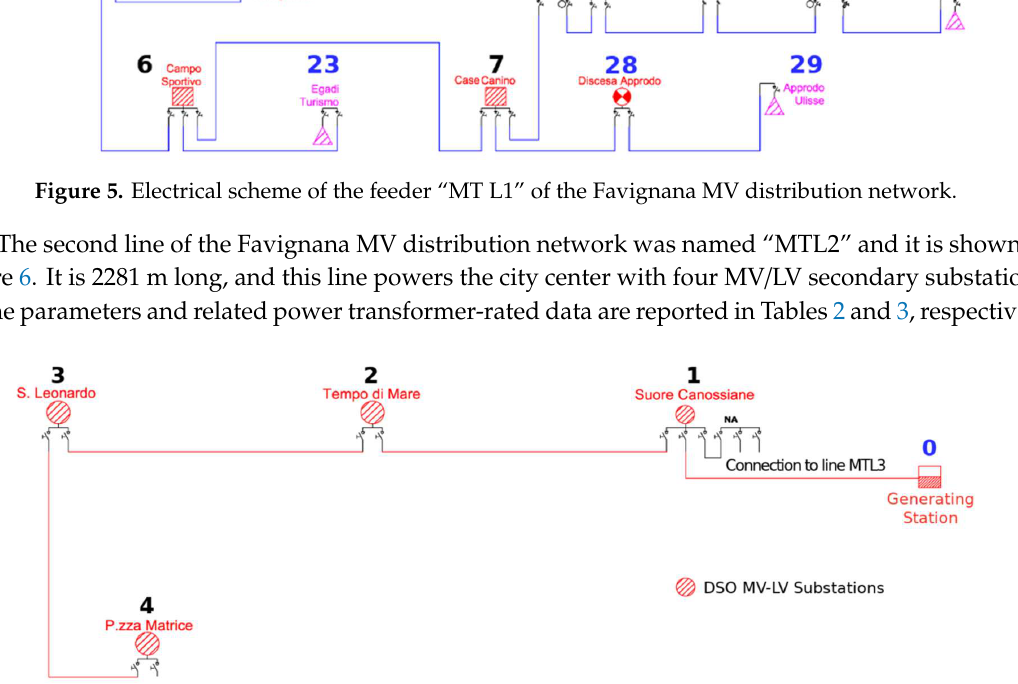
Figure 6. Electrical scheme of the feeder “MT L2” of the Favignana MV distribution network.